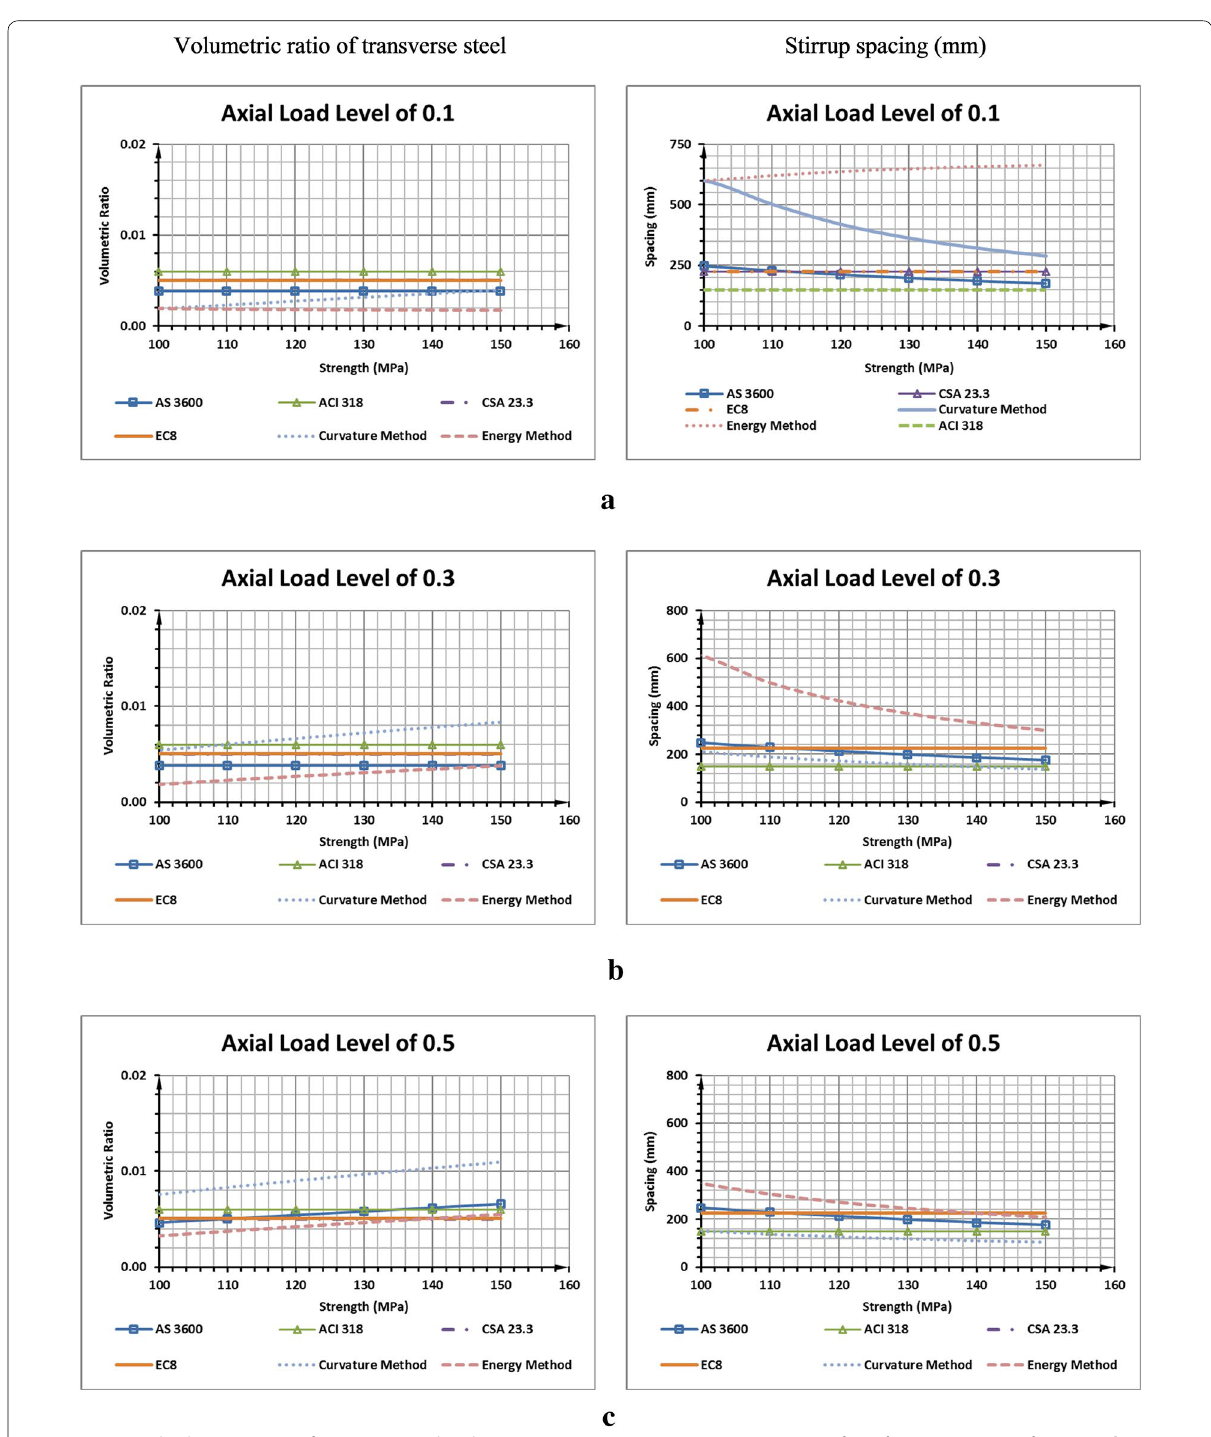
Fig. 15 Required volumetric ratio of transverse steel and stirrup spacing ( ρ sl 0.3, c P /f co A c f co A c =